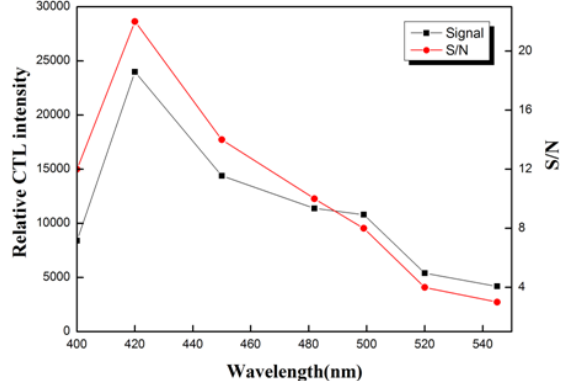
O nanomaterial. 2 3